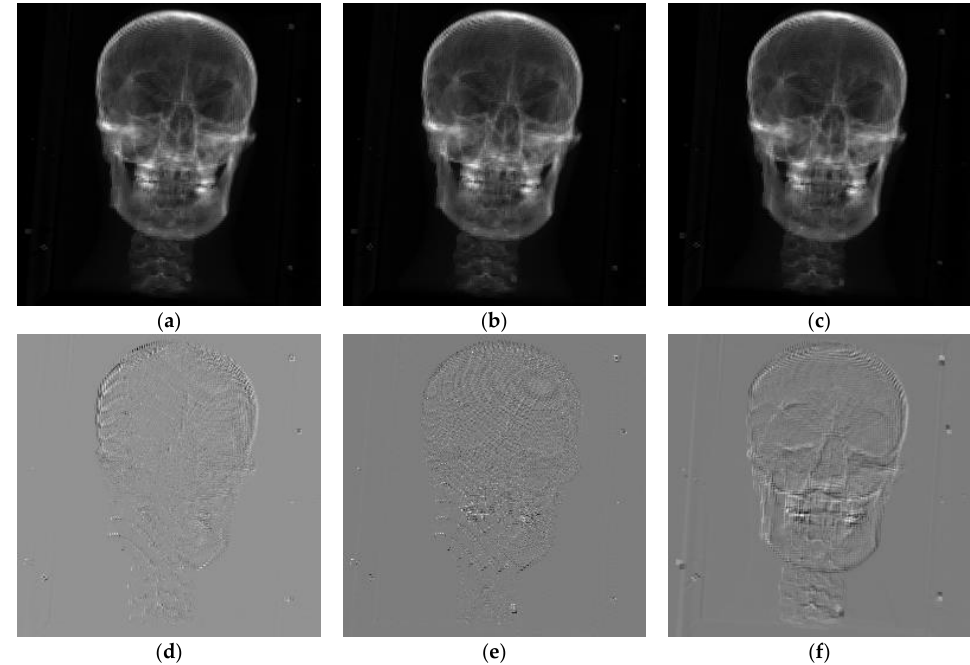
Figure 8. Experimental results of group 2. ( a ) DRR based on NCCS registration; ( b ) DRR based on NCCL registration; ( c ) DRR after registration based on NCC; ( d ) difference map after registration based on NCCS; ( e ) difference map after registration based on NCCL; ( f ) difference map after registration based on NCC.